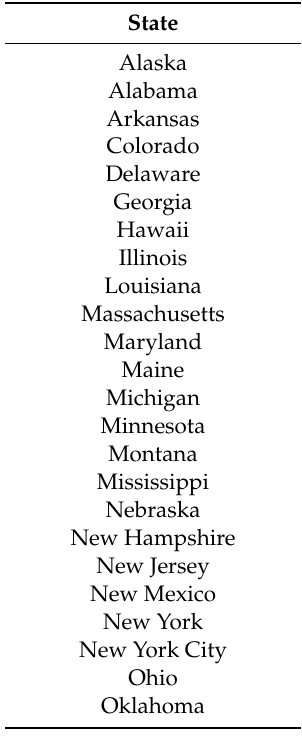
Table A1. List of States in the Analytic